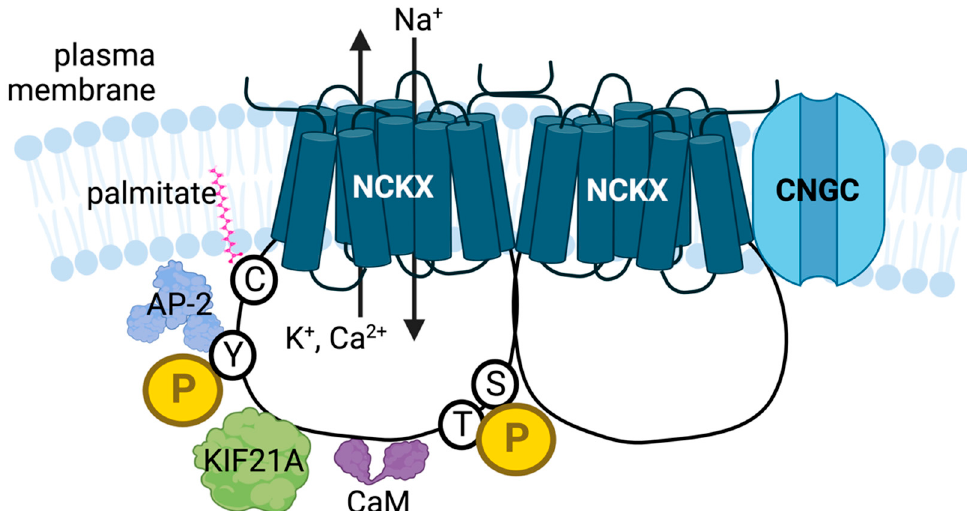
Figure 2. The different known NCKX post-translational modifications and allosteric regulation steps are illustrated. Protein complex formation . The NCKX protein is shown in the membrane as a homodimer. In photoreceptors, the NCKX dimer is known to interact with the CNGC subunits, CNGA1 and CNGA3. Interactions with CaM, KIF21A and AP-2 are also illustrated. The latter two proteins likely also influence NCKX distribution between different membrane compartments. Phosphorylation . NCKX is modulated by phosphorylation (P) on either tyrosine (Y), serine (S) or threonine (T) residues. SFK-mediated phosphorylation of a Y residue is thought to interfere with the AP-2 interaction required for retrieval of NCKX2 from the plasma membrane into endosomes. CaM is thought to interact with phosphorylation mediated by PKC and/or CaMKII to provide complex temporal control over NCKX4 activity. Palmitoylation . Modification of a cysteine (C) residue with palmitate is thought to modulate NCKX4. For simplicity, modifications are only illustrated on one subunit of the NCKX dimer.